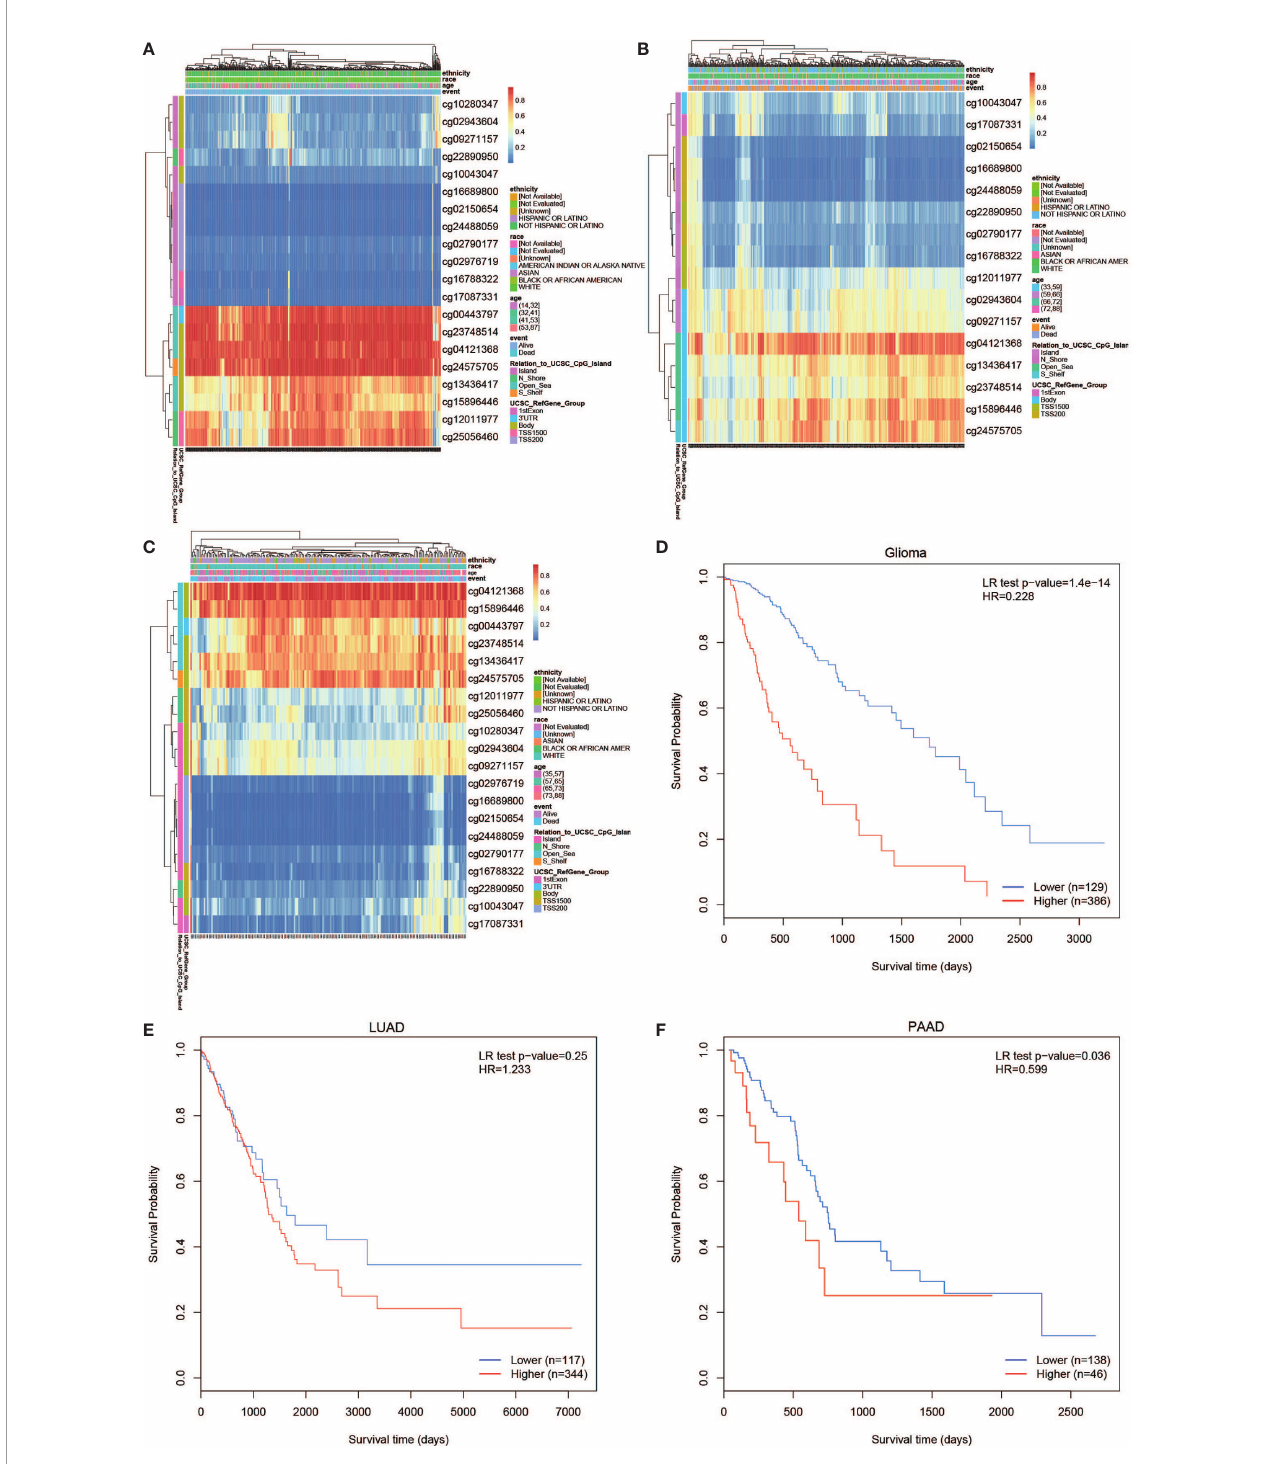
FIGURE 5 | The prognostic value of the DNA methylation of PLPP4 signature in glioma, LUAD, and PAAD via SurvivalMeth. (A) The heat map of DNA methylation clustered expression level of PLPP4 in glioma. (B) The heat map of DNA methylation clustered expression level of PLPP4 in LUAD. (C) The heat map of DNA methylation clustered expression level of PLPP4 in PAAD. Notes: cg04121368 of PLPP4 showed the highest DNA methylation level in glioma, LUAD, and PAAD. (D – F) The survival curve of the Kaplan – Meier